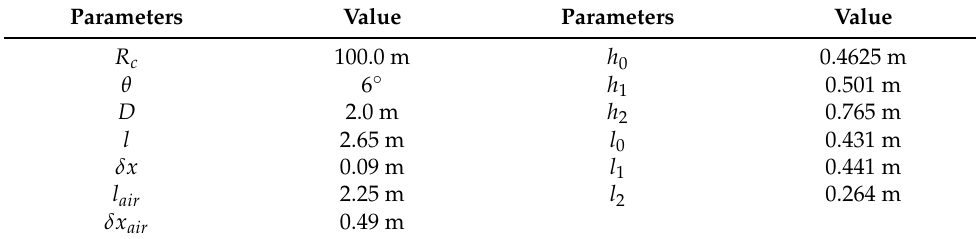
Table 1. The parameters of the circular curve and the maglev train.